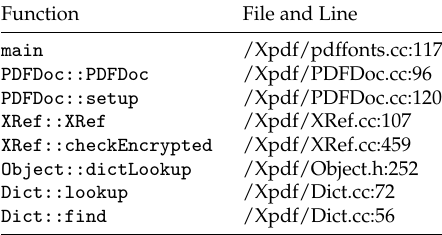
Figure 1. The motivating